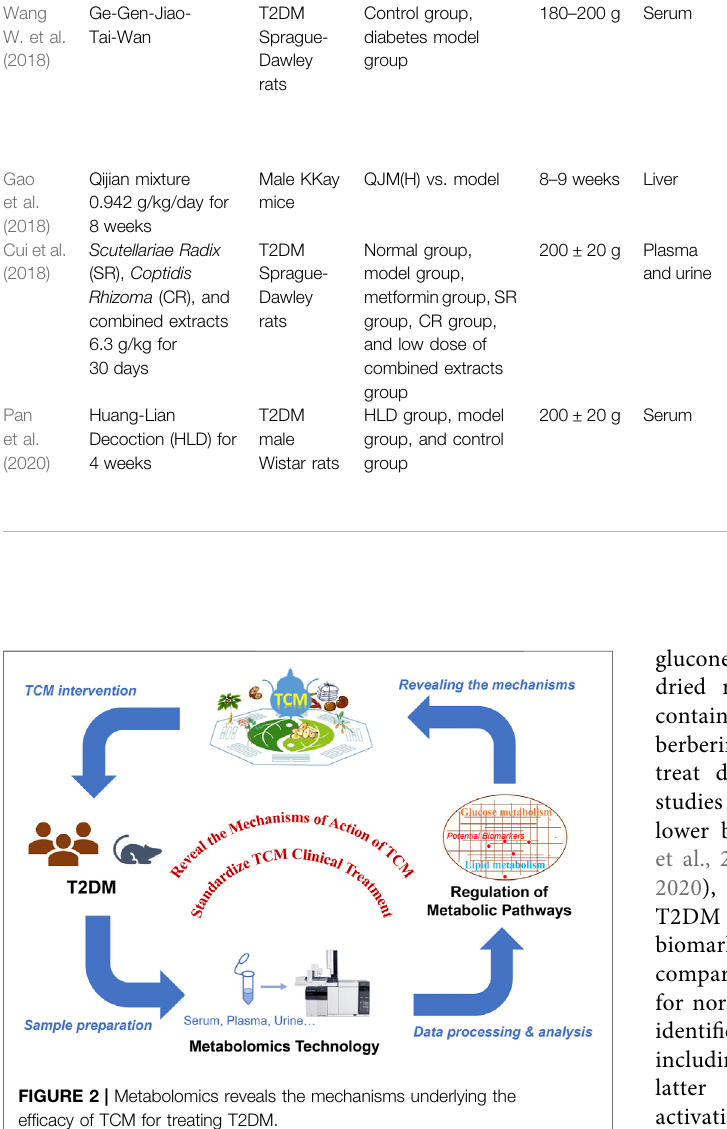
Frontiers in Pharmacology |